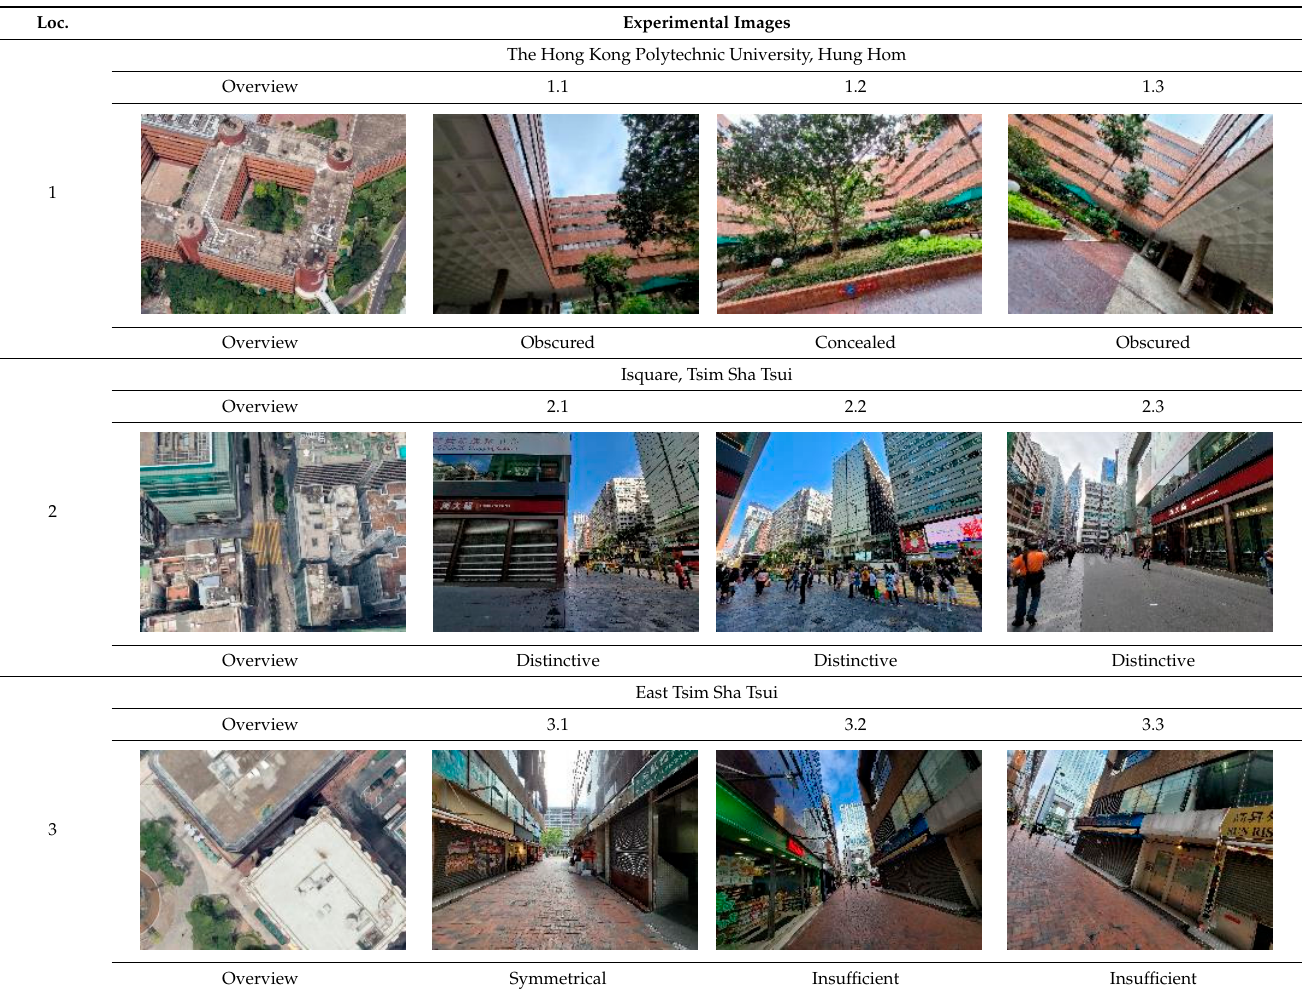
Table 2. Locations and images tested with the proposed semantic VPS method. Loc.